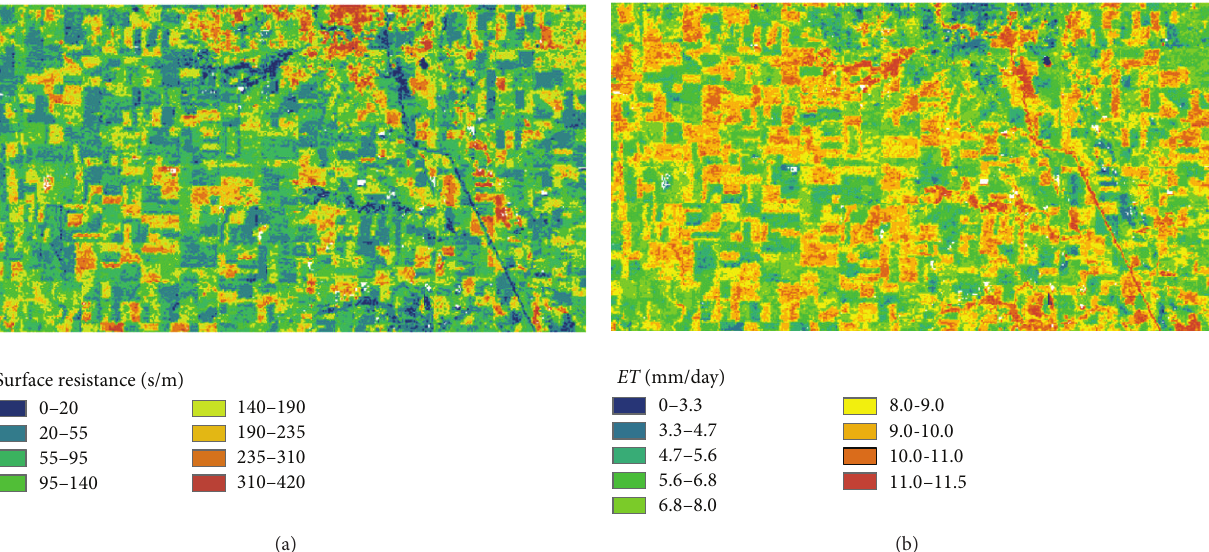
Figure 9: Surface resistance (s/m) and daily 𝐸𝑇 (mm/day) estimated from Landsat based variables over Walnut Creek catchment for July 1, 2002.